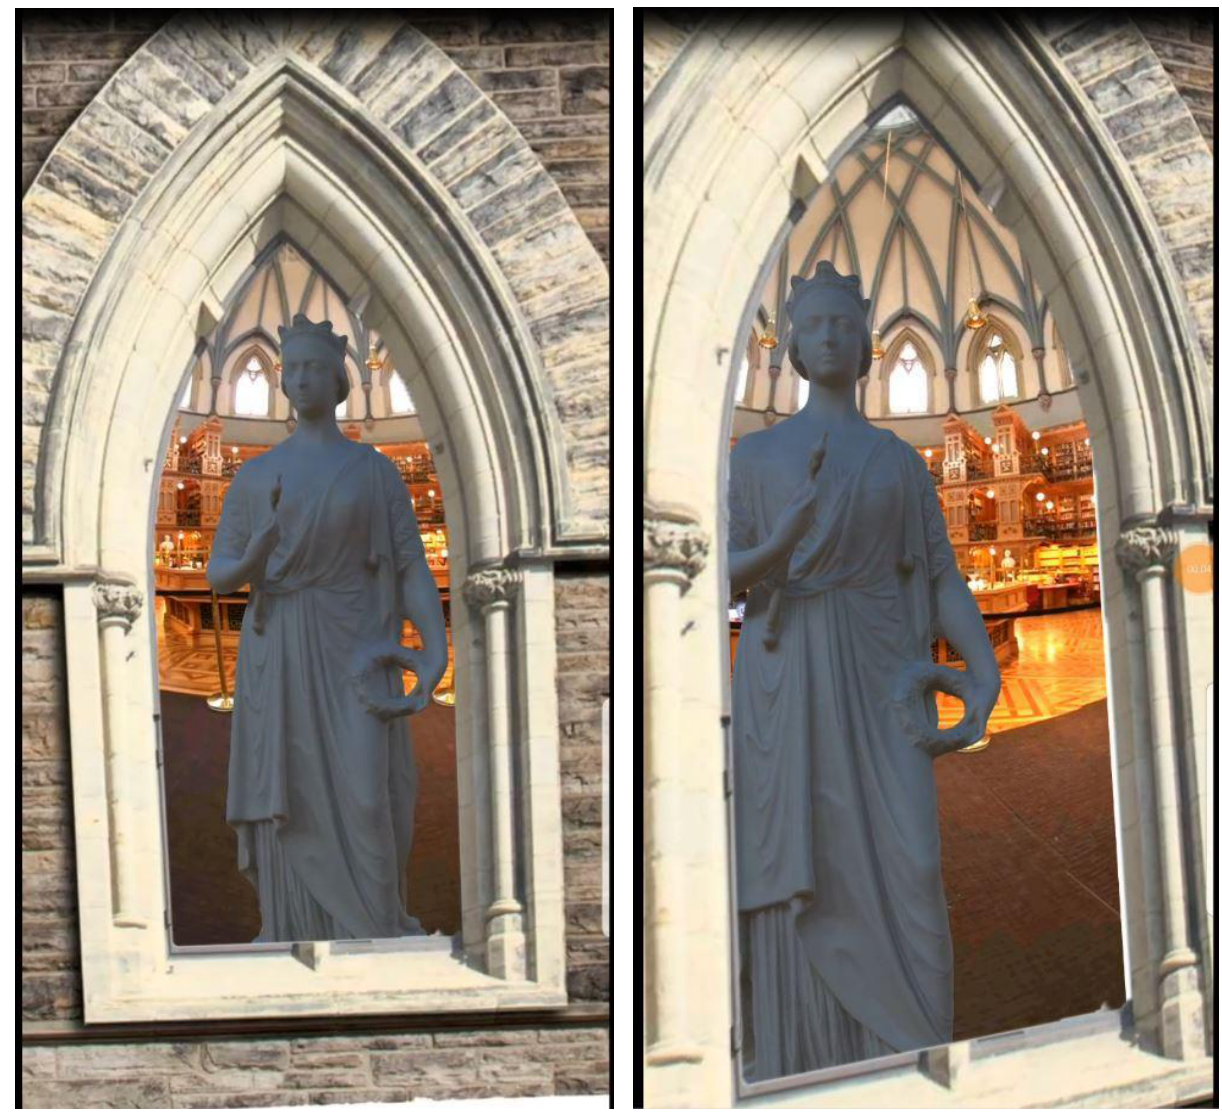
Figure 7. AR app